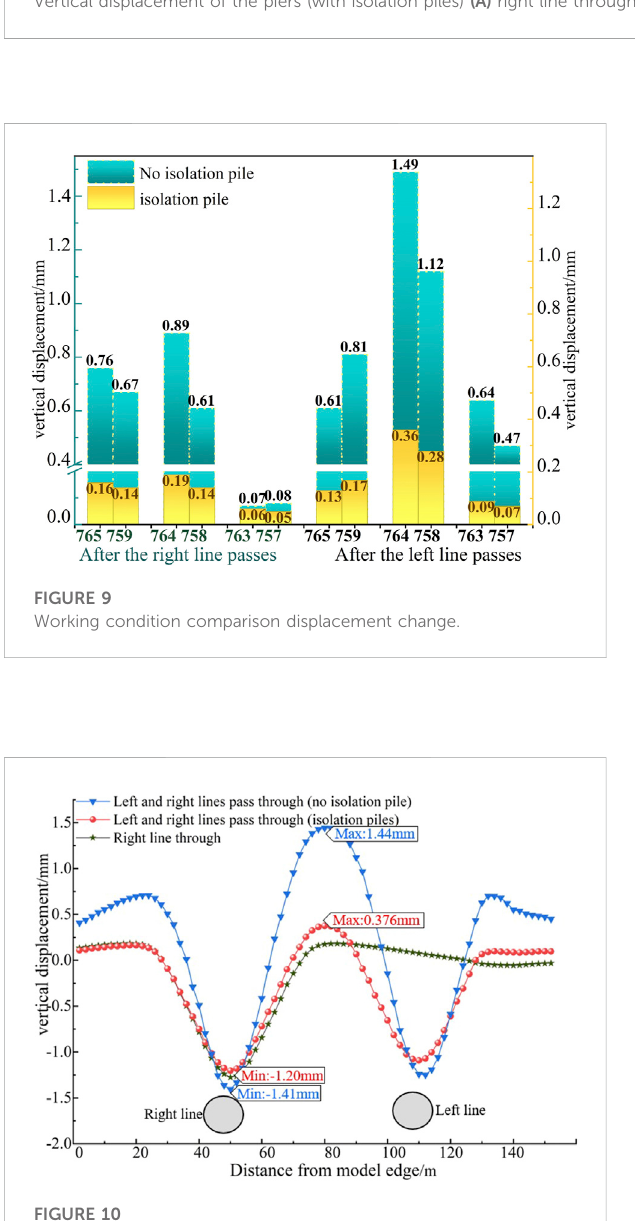
FIGURE 10 Vertical displacement of the ground surface.